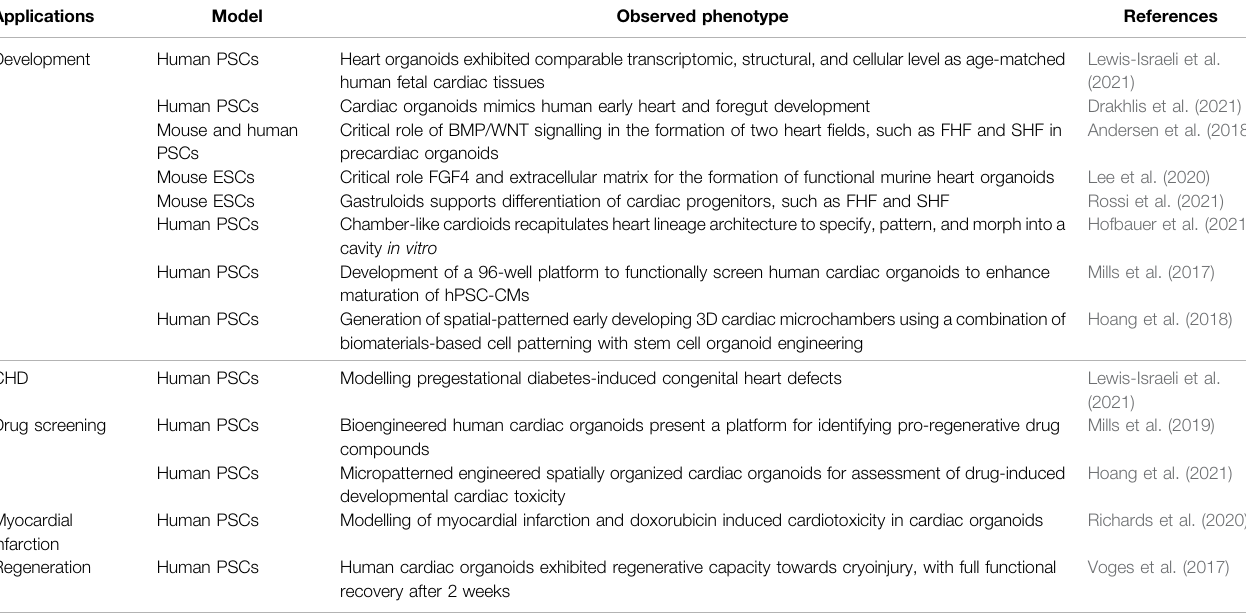
TABLE 2 | Summary of recent developed organoid systems and their contribution to cardiogenesis and disease modelling research.